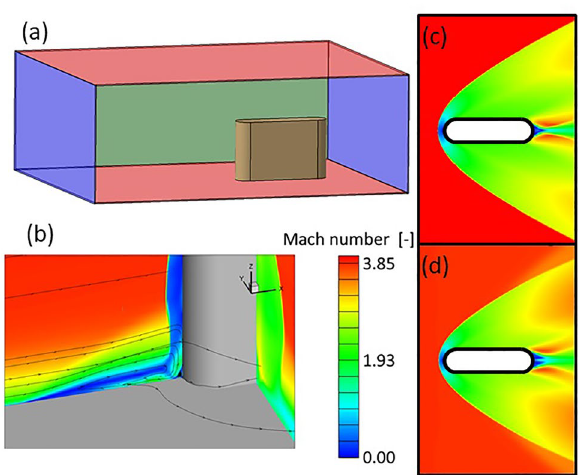
Figure 5. Computational domain ( a ), Mach contour slices and streamlines at 3D region at the leading edge ( b ), Mach contour corresponding to a 2D simulations ( c ), Mach contour cut on 2D region from 3D simulation ( d ) for a supersonic